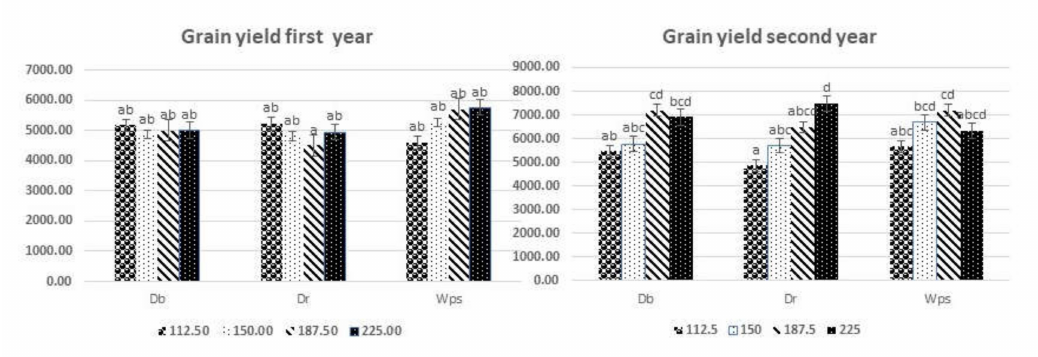
Figure 4. The e ff ects of the sowing methods and seed rate on the grain yield in the both cropping seasons. Db, Dr, and Wps represent the sowing methods dibbling, drilling, and wide precise sowing, respectively. 112.5, 150, 187.5, and 225 represent the winter wheat (Xinong805) sown at 112.5 kg ha − 1 , 150 kg ha − 1 , 187.5 kg ha − 1 , and 225 kg ha − 1 , respectively. Vertical bars represent standard errors ( n = 3), in the same cropping year; the same letters above the bars indicate no significant di ff erences between the di ff erent treatments ( p <